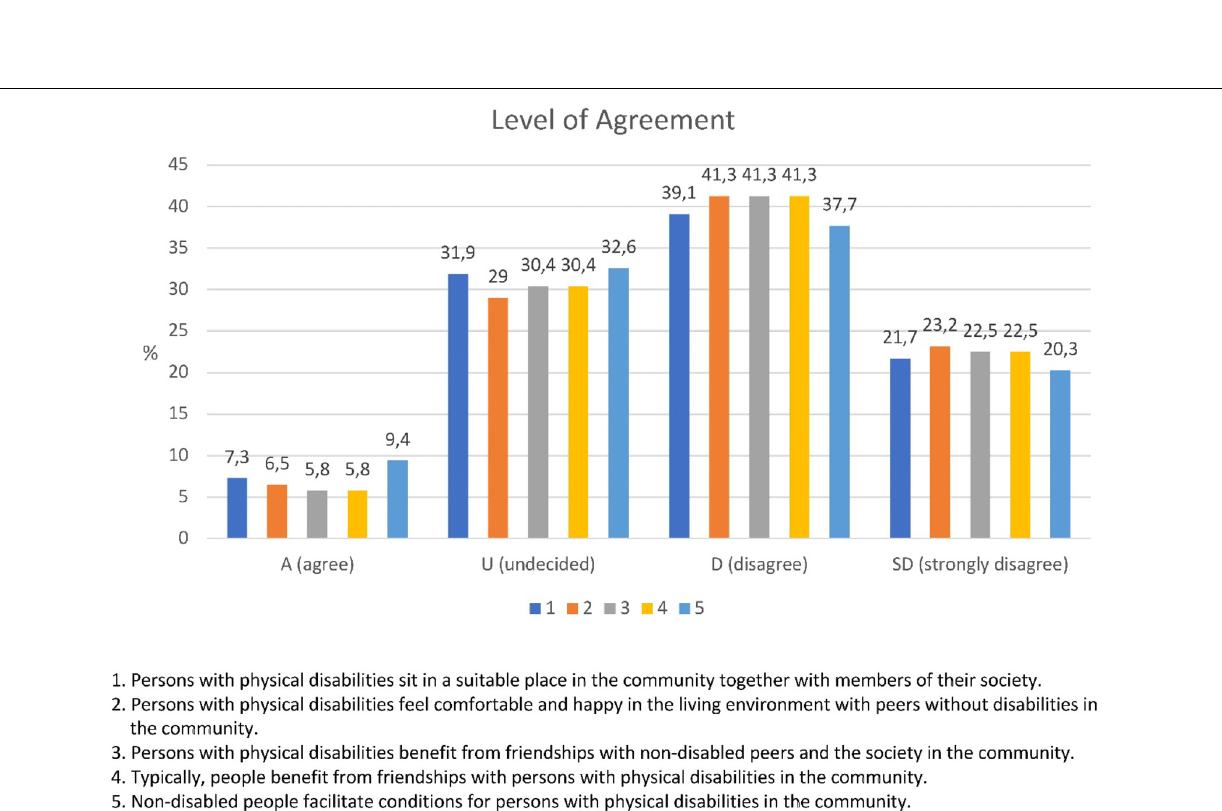
FIGURE 9 | Interaction between persons with disabilities and the